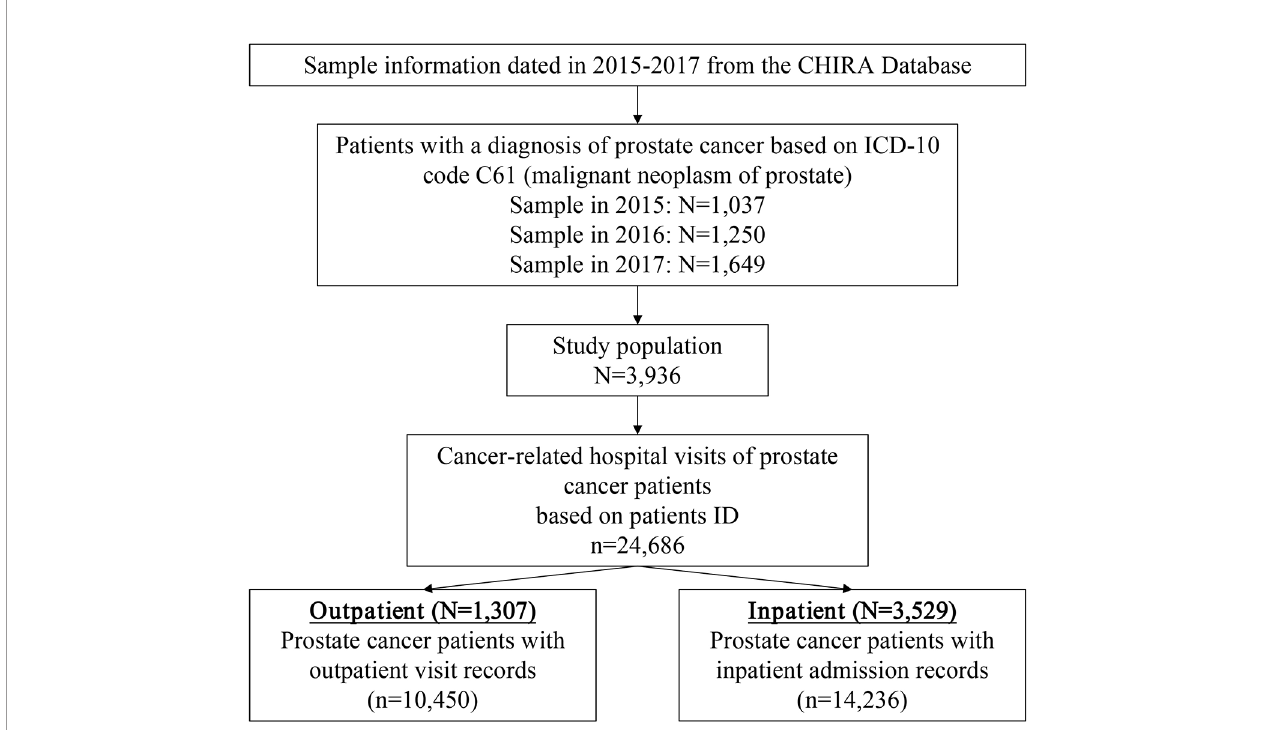
FIGURE 1 | Diagram of sample identi fi cation process from the CHIRA database. CHIRA, the China Health Insurance Association; ICD-10, the International Classi fi cation of Diseases 10th